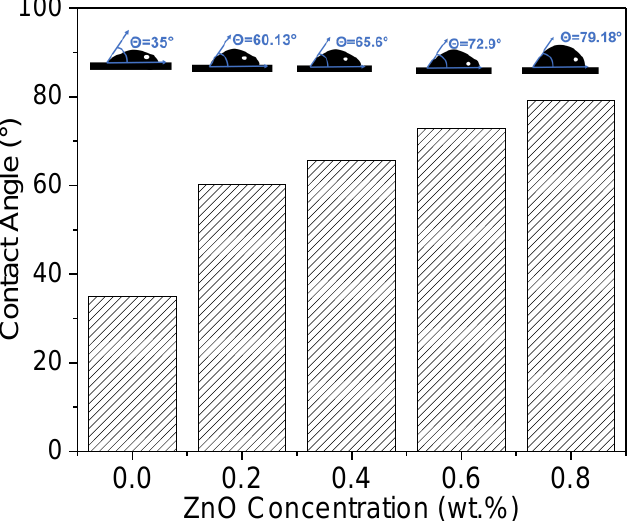
Figure 6. CA (contact angle) image of 0% – 0.8% concentration of zinc oxide nanoparticle.